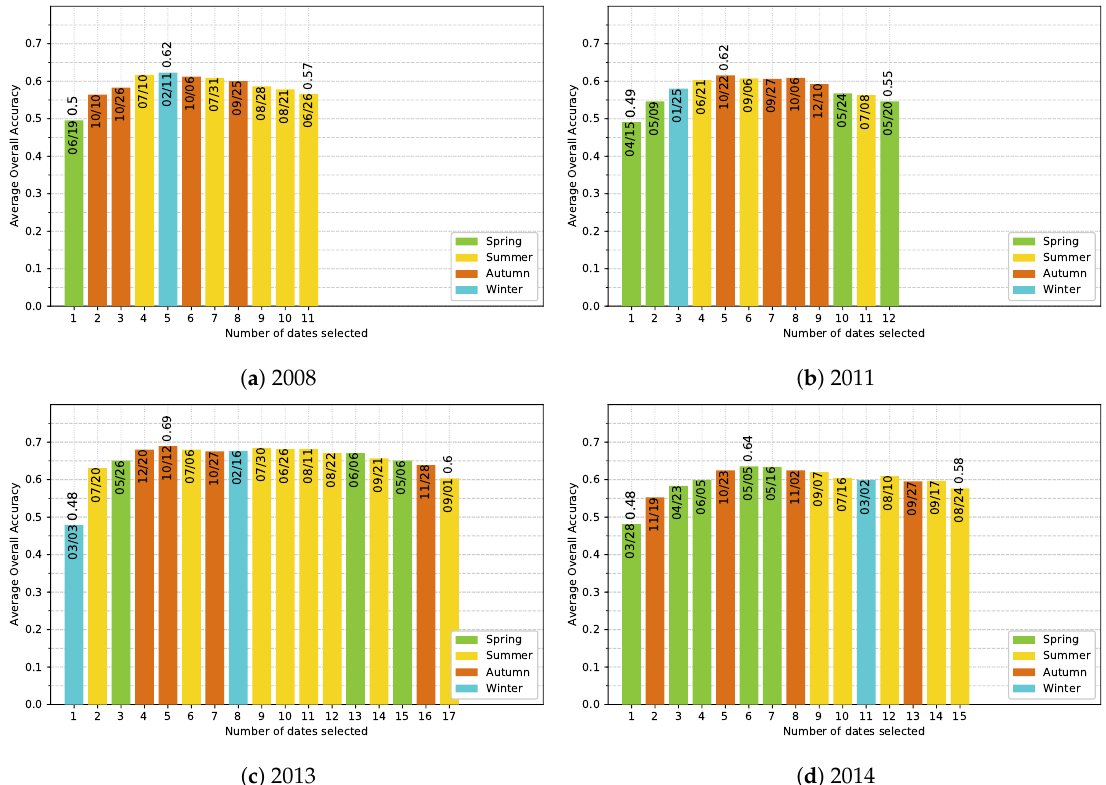
Figure 13. Ranking-based feature selection of image dates for single-year classification of 2008 ( a ), 2011 ( b ), 2013 ( c ), 2014 ( d